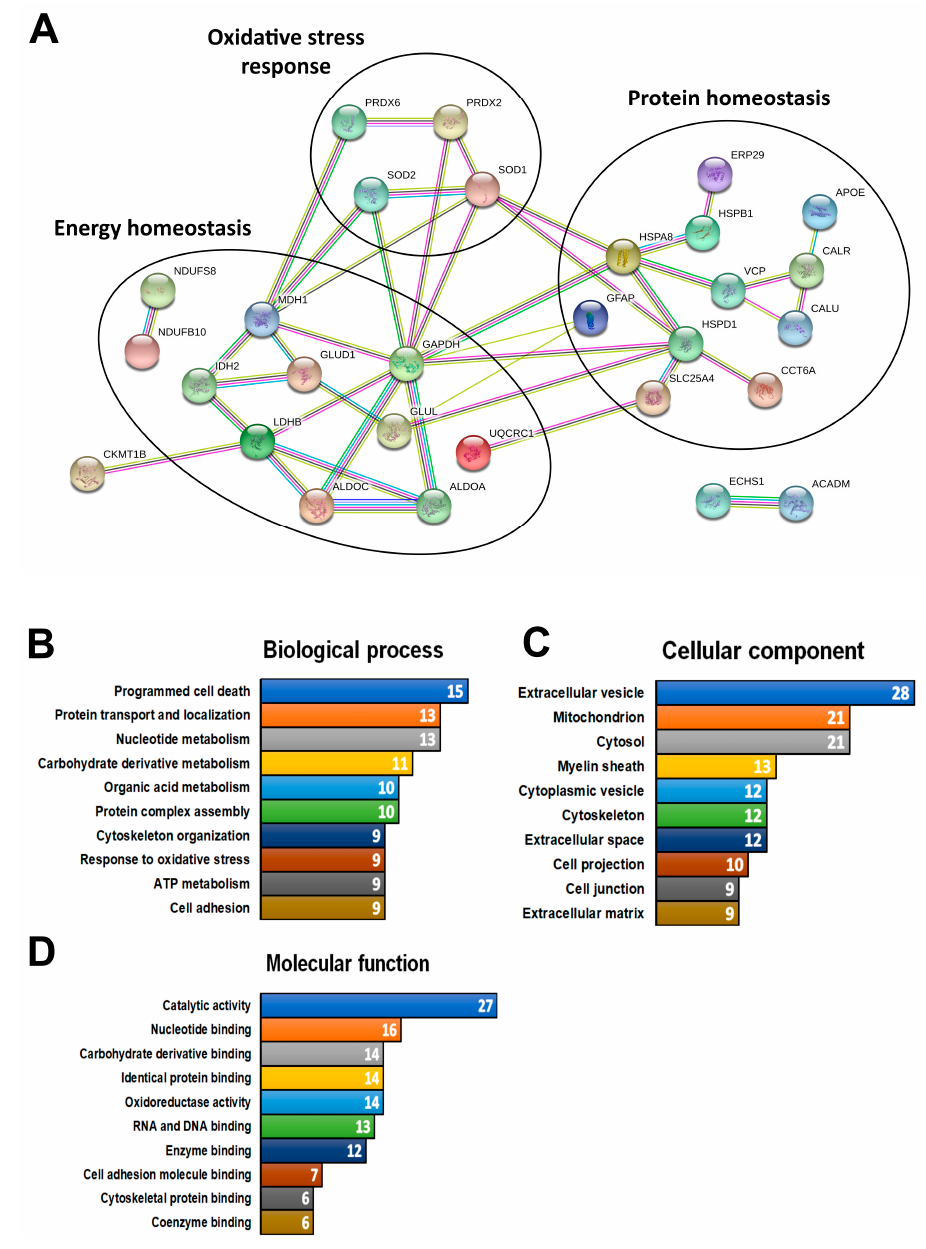
Figure 1. Bioinformatics analysis of the proteins consistently changed in the same direction in amyotrophic lateral sclerosis (ALS) tissues and cells. ( A ) Search Tool for the Retrieval of Interacting Genes/Proteins (STRING) 10 association network showing only the proteins that demonstrated association. The type of association between proteins is indicated by the color (pink: experimentally determined interactors; light blue: interactors form curated database; grey: protein homology; black: co-expression; yellow: text-mining; dark blue: gene co-occurrence; green: gene neighborhood). Three functional groups of proteins associated with regulation of oxidative stress, energy homeostasis and protein homeostasis were identified in the network from Figure 1B. Gene ontology (GO) term analysis using the DAVID platform revealed enriched terms connected to ( B ) biological processes, ( C ) cellular component and ( D ) molecular function. The top 10 terms from each domain were presented as bars. White numbers inside the bars indicated the number of annotated proteins. The full list of terms together with annotated proteins is available in Table